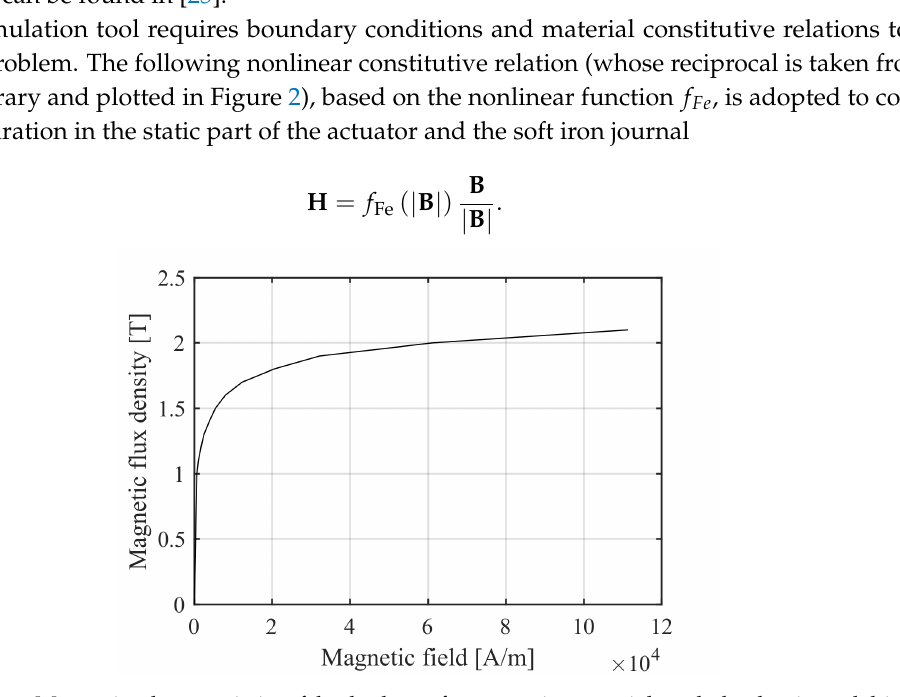
Figure 2. Magnetic characteristic of both the soft magnetic material and the laminated high permeability